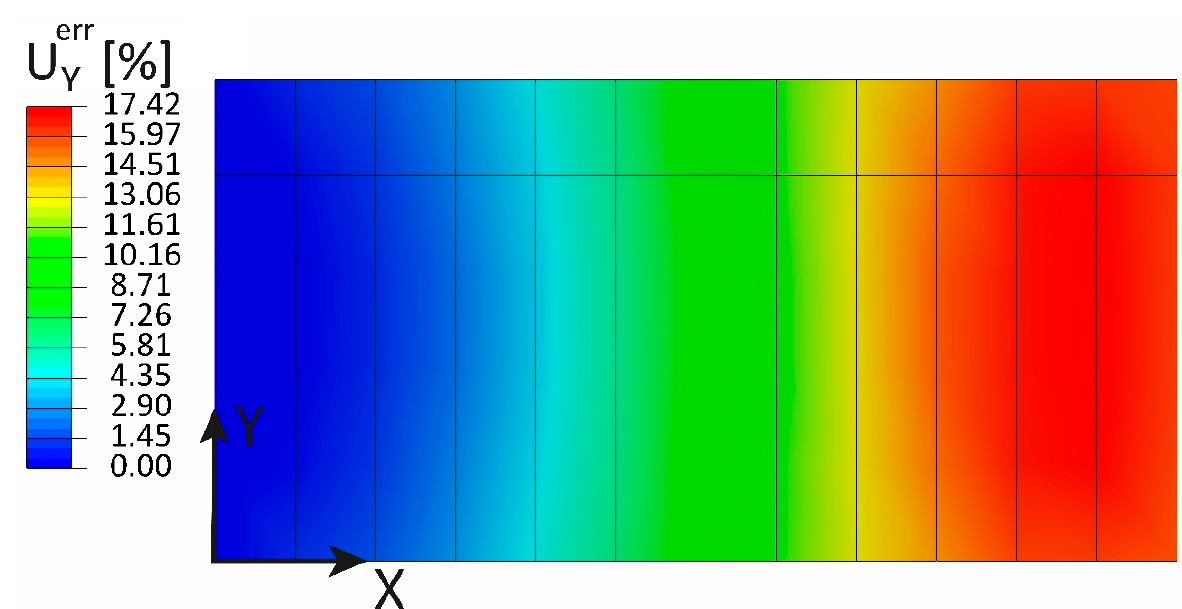
Figure 19 . Shear loading: percentage error of the 𝑈 (cid:3026) displacement. Figure 19. Shear loading: percentage error of the U